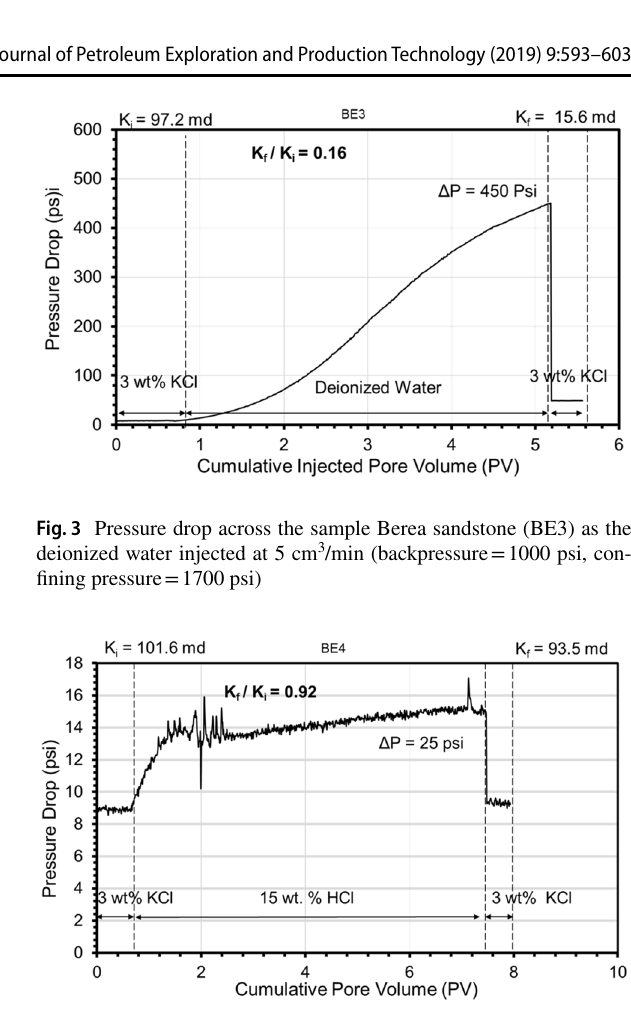
Fig. 4 Pressure drop across the sample Berea sandstone (BE4) as the 15 wt% HCl injected at 5 cm 3 /min (backpressure = 1000 psi, confin- ing pressure = 1700